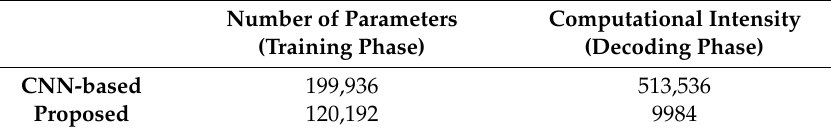
Table 3. Computation complexity of trigger word detection